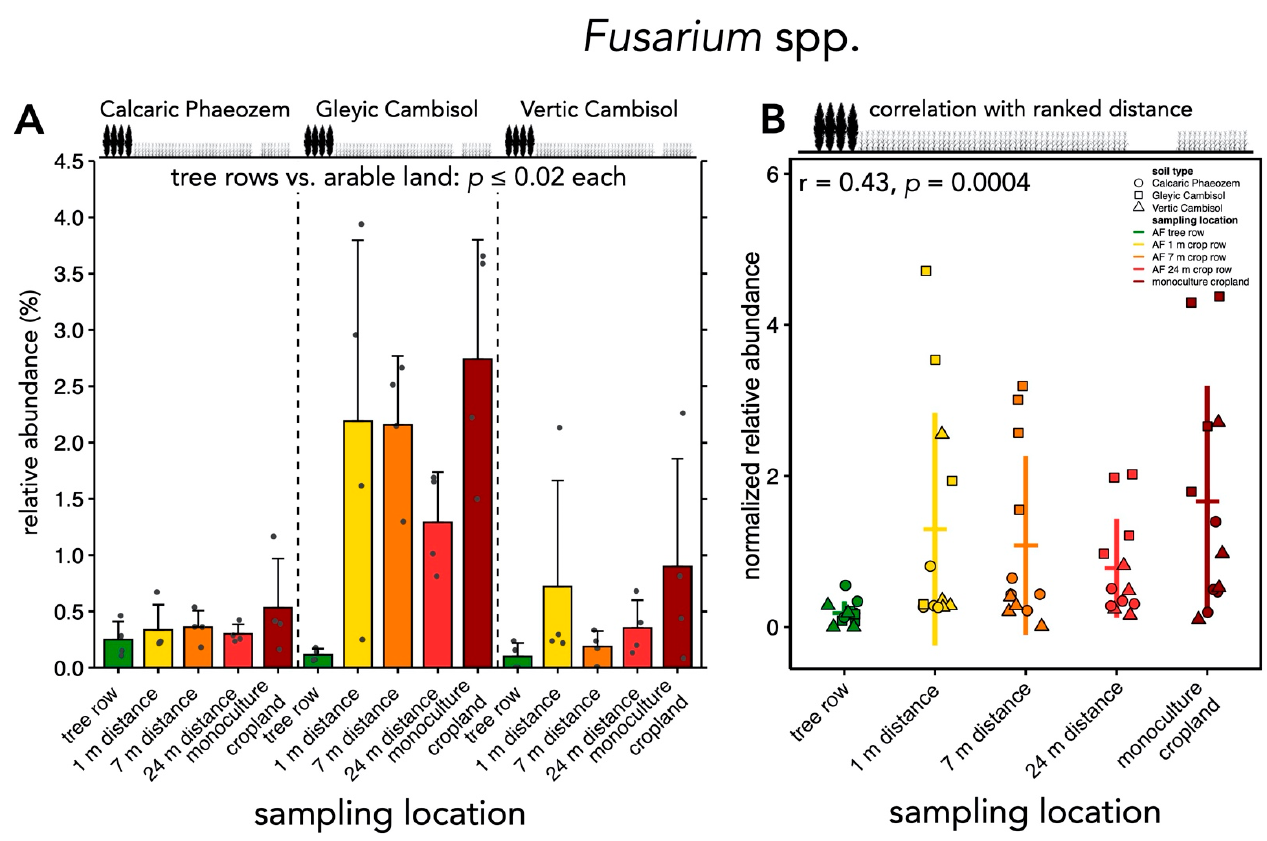
Figure 8. Relative abundance of Fusarium spp. and correlation with distance from the tree rows. ( A ) Relative abundances of Fusarium spp. were calculated from ASV counts obtained by amplicon sequencing. The mean gene copy number with standard deviation ( n = 4) are shown. Grey dots represent individual data points. Differences between sampling locations (tree row, 1 m, 7 m, and 24 m distance from the tree row within the crop row and monoculture cropland) were tested using linear mixed effect models with sampling location as fixed effect and site as random effect. Only differences between tree rows and arable land (1 m, 7 m, and 24 m distance from the tree row within the crop row and monoculture cropland) are reported in the panel. ( B ) Spearman rank correlation of relative abundance of Fusarium spp. with distance from the tree rows. Absolute fungal 18S rRNA gene abundances were normalized by the mean per site; distances from the tree rows were ranked (1 st rank: tree row, 2 nd rank: 1 m crop row, 3 rd rank: 7 m crop row, 4 th rank: 24 m crop row, 5 th rank: monoculture cropland) prior to correlation analysis. In all panels, circles, squares and triangles represent individual samples ( n = 4) from Calcaric Phaeozem, Gleyic Cambisol and Vertic Cambisol soil, respectively. Horizontal and vertical bars represent the mean and standard deviation,